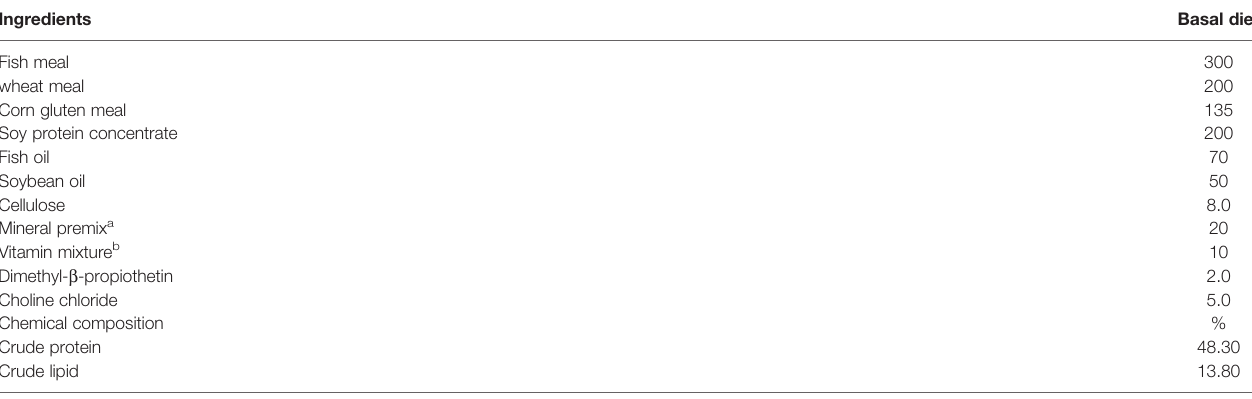
TABLE 1 | Compositions of the basal diet (g/kg) for rainbow